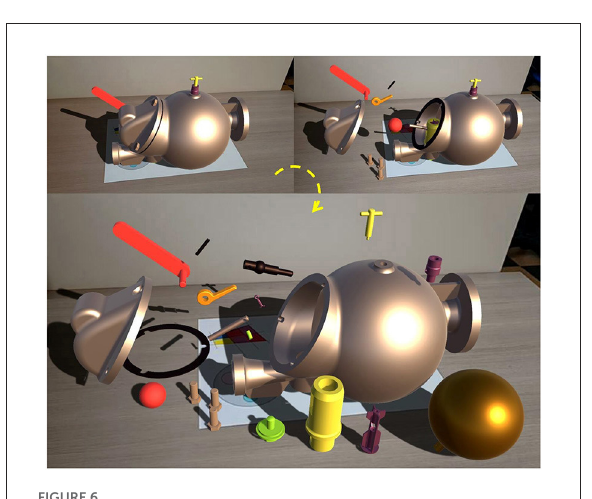
FIGURE6 Different removal phases of the assembly components in augmented reality shown